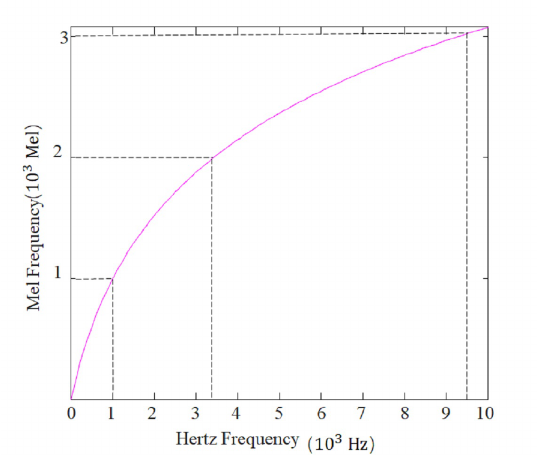
Figure 6. Transformation between the Hertz and Mel frequencies.